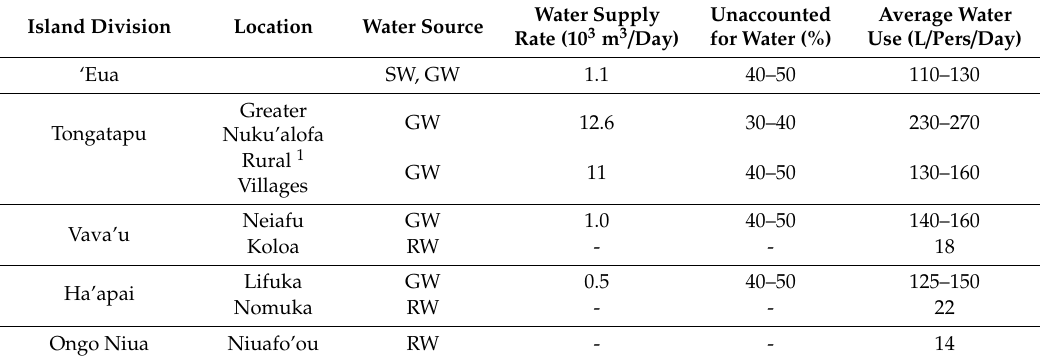
Table 3. Estimated average per capita water use, Equation (2), in population centers and measured use in some rural villages in Tonga’s Island Divisions supplied by spring water (SW), groundwater(GW) and rainwater (RW)